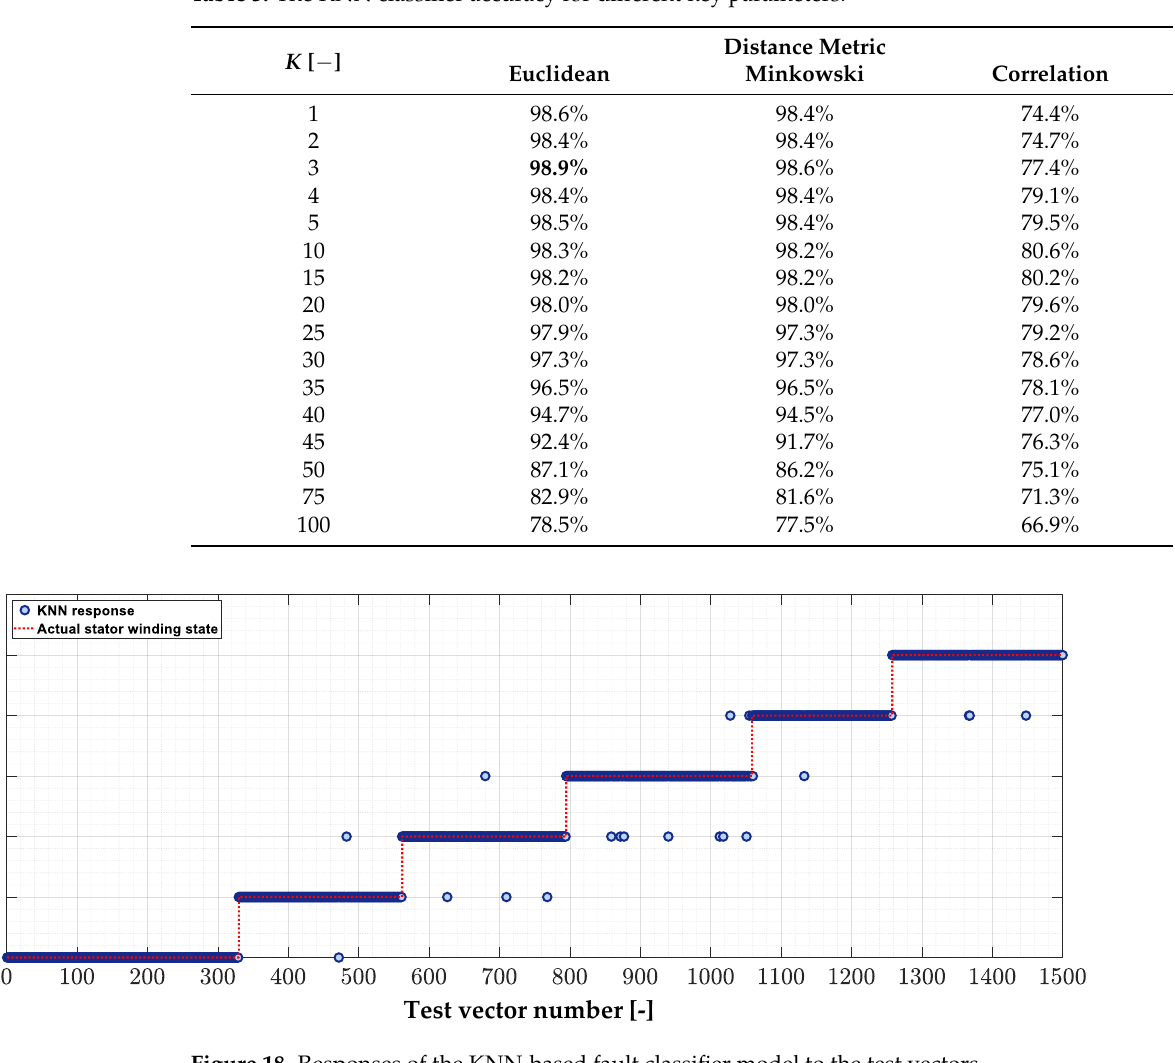
Table 3. The KNN classifier accuracy for different key parameters.